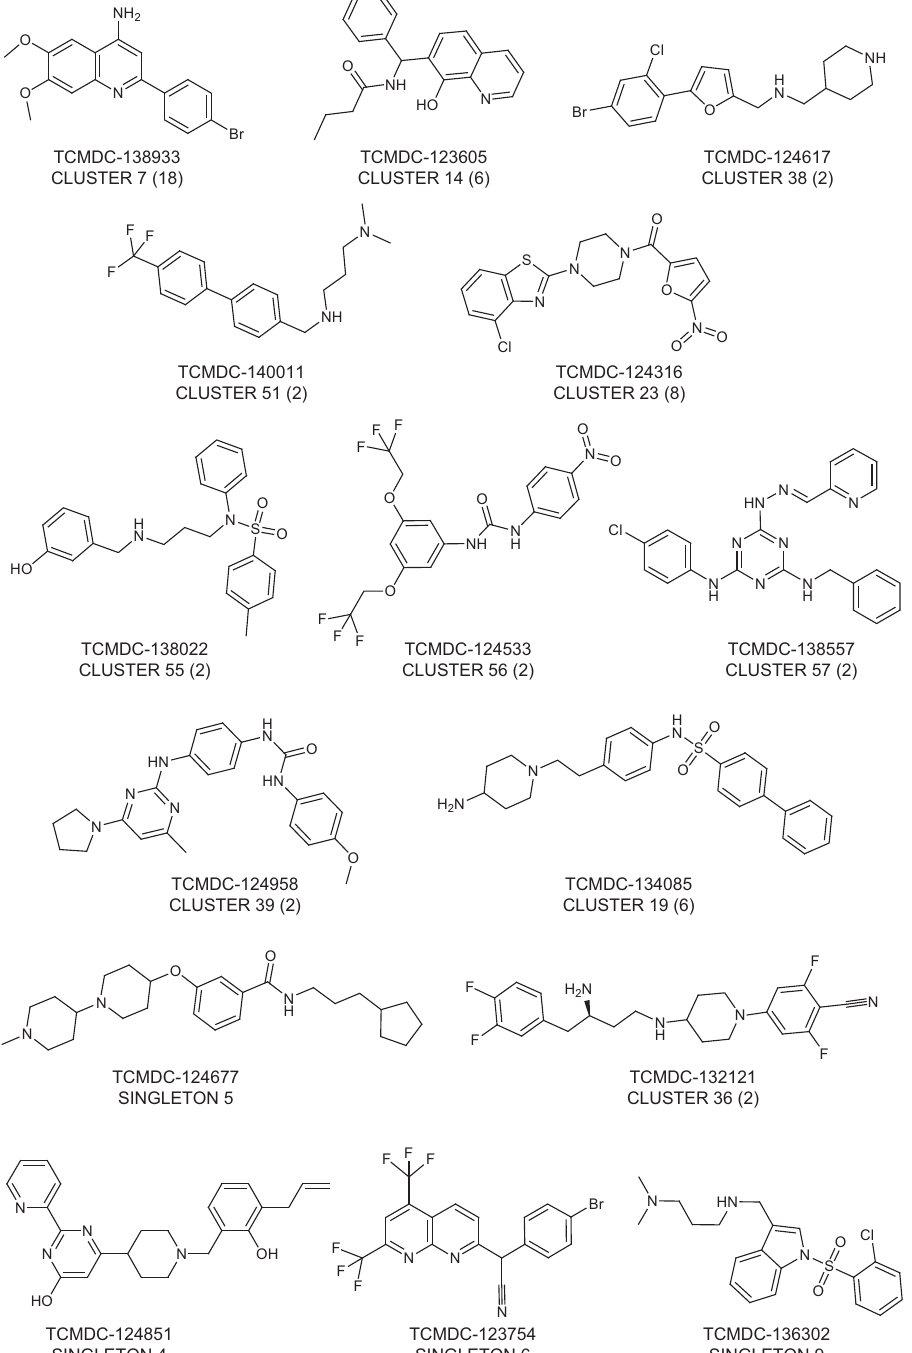
Figure 3 | TCAMS chemical series representatives of the compound set further progressed. Scaffolds of 15 chemotypes, belonging to 24 of the 90 compounds profiled, that are within an appropriate physicochemical space (clogP o 5, number of aromatic rings o